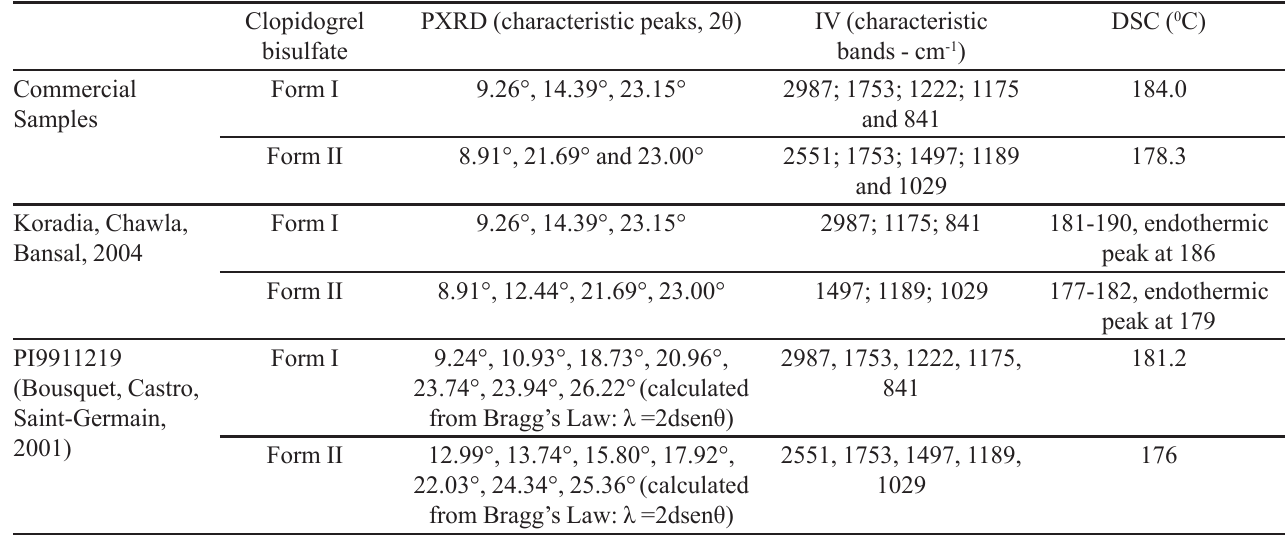
TABLE IV – Experimental data of IR, PXRD and DSC for the polymorphic forms I and II of clopidogrel bisulfate